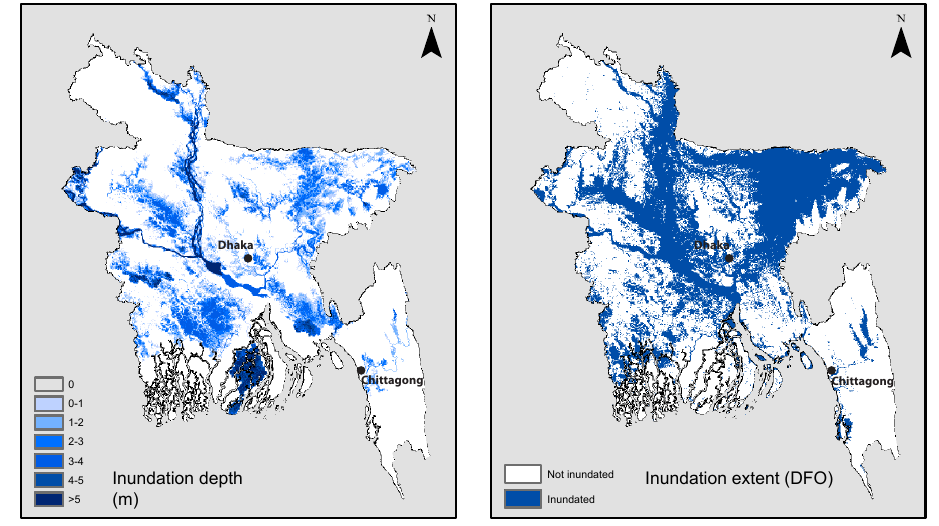
Fig. 5. Validation of flood hazard map over Bangladesh. The left subfigure shows the inundation depth of the 30yr return period from GLOFRIS. The right figure shows the outline of areas that have been inundated at least once on the full Dartmouth flood Observatory (DFO) record